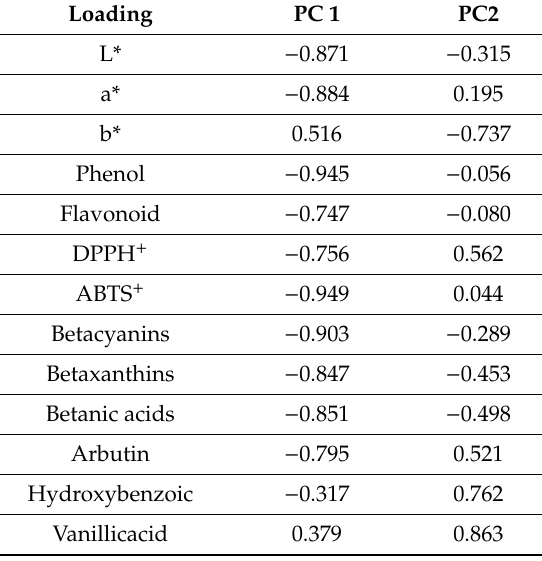
Table 2. Factor loading, eigenvalue, cumulative variance (%) and score for the first two principal (PC1. and PC2) components of amaranth extract based on extraction methods.